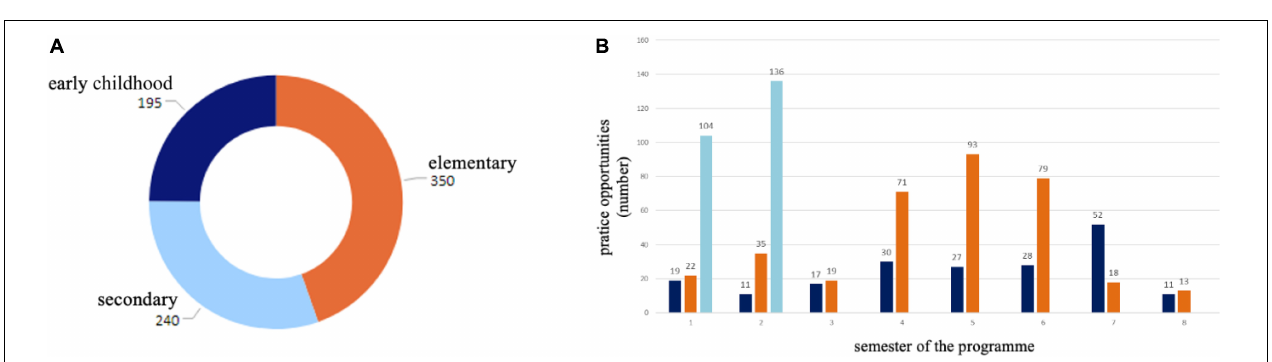
FIGURE 1 | Instruments and information sources.